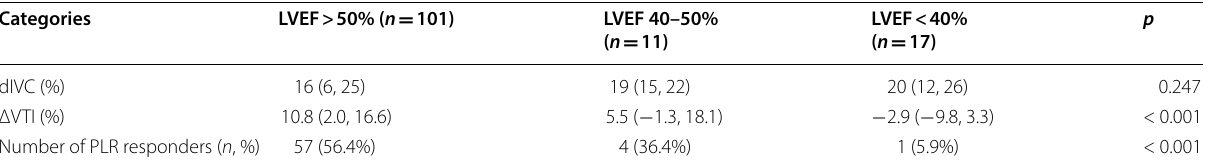
Table 4 dIVC and ΔVTI in patients with different